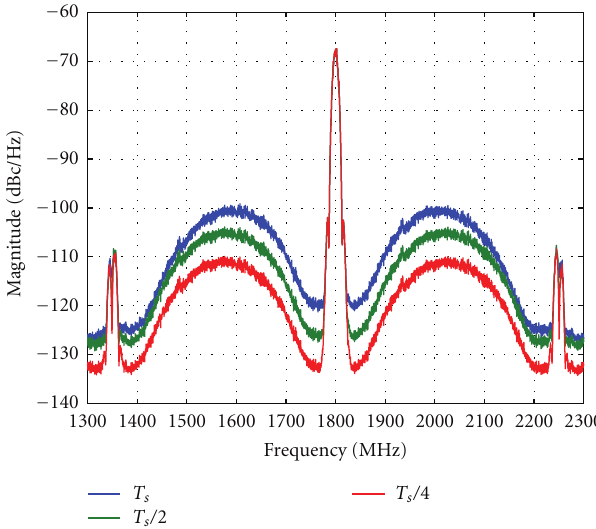
Figure 10: The simulated PSD of a GFSK-modulated signal show- ing PQN reduction with decrease in integration